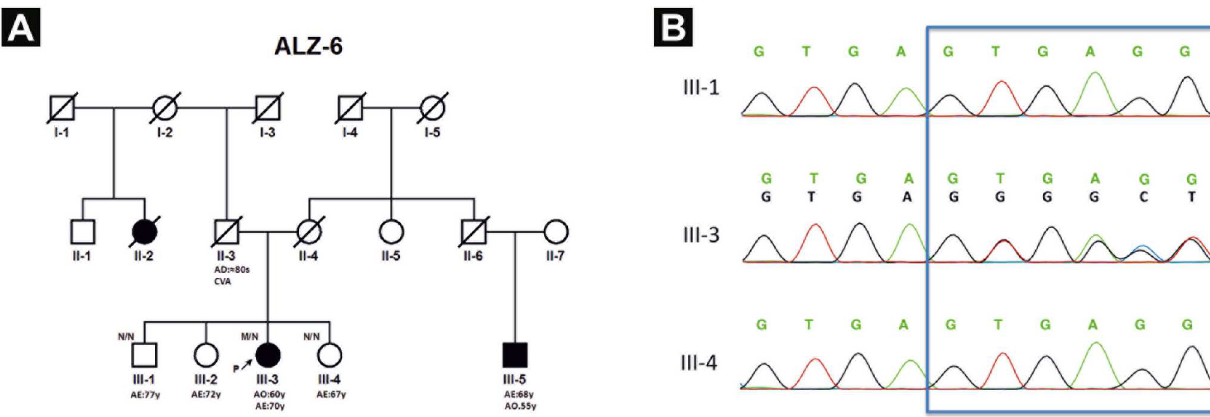
Fig 2. ALZ-6familypedigreeand sequencingchromatograms. (A) The arrow indicatesthe proband.Black filled symbols: affected patients; white symbols:unaffected family members. N: Normal,M: the c.708+6_9delTGAG deletion.CVA: cerebralvascular accident,AO: age at disease onset,AD: age of death.(B) Sequencing chromatograms show the presence of GRN c.708+6_9delTGAG deletionin the index patient III-3that is not seen in individualsIII-1and III-4.